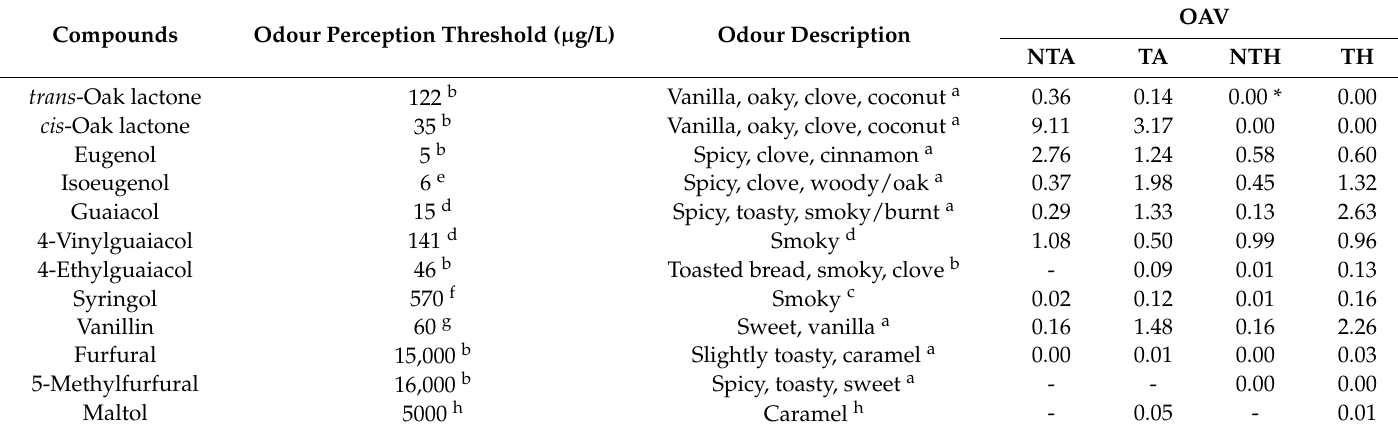
Table 2. Odour perception thresholds. Odour descriptions and odour activity values (OAV) of volatile oak-related compounds in Chardonnay wines macerated with non-toasted and toasted Hungarian ( Q. petraea ) and American ( Q. alba ) oak chips during 25